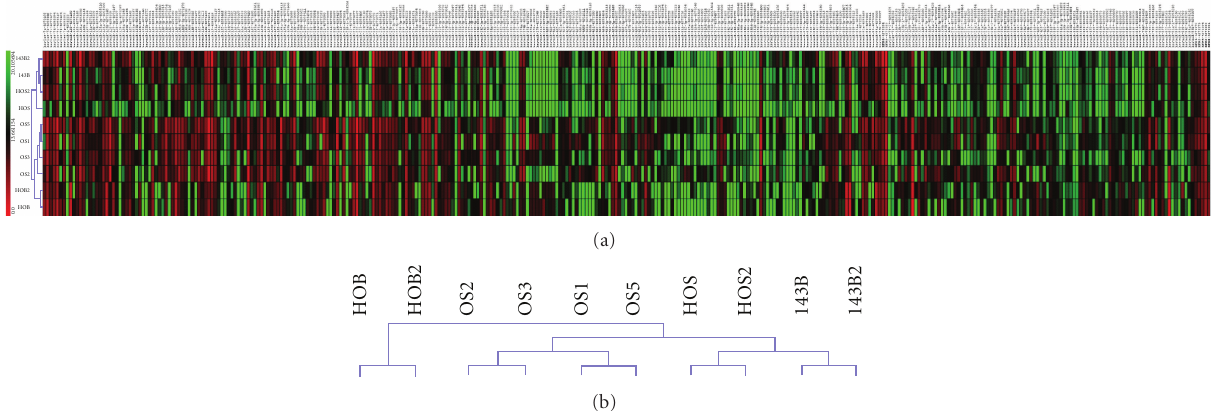
Figure 1: Heat Map showing unsupervised hierarchical clustering performed using Pearson’s correlation (Multiexperiment Viewer, Version 4.5.1). Relative expression values from normal osteoblasts (HOB), 2 osteosarcoma cell lines (HOS and 143B), and 4 human tumors samples (OS 1, 2, 3, and 5) are represented in the main tree (a). A higher magnification of the column dendrogram showing that each group clusters together suggesting that the samples have similar miRNA expression profiles (b). Table 1: Fold change di ff erences from 22 miRNAs comparing human tumor samples, osteosarcoma cell lines, and normal osteoblasts. miRNA Tumors versus control ∗ Cell lines versus control ∗ Tumors versus cell lines ∗ hsa-miR-126 652.38